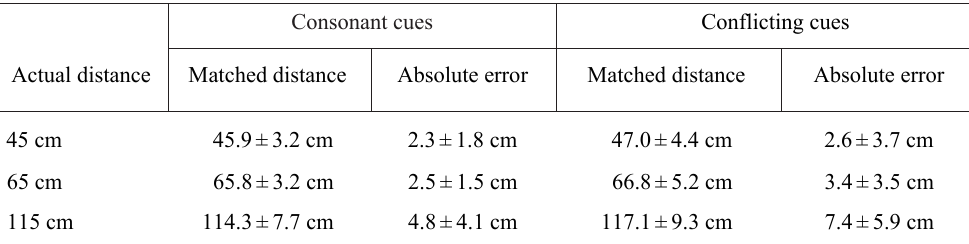
Table 1. Means and standard deviations of the accuracy of perceptual distance matching in the consonant cues condition and the conflicting cues